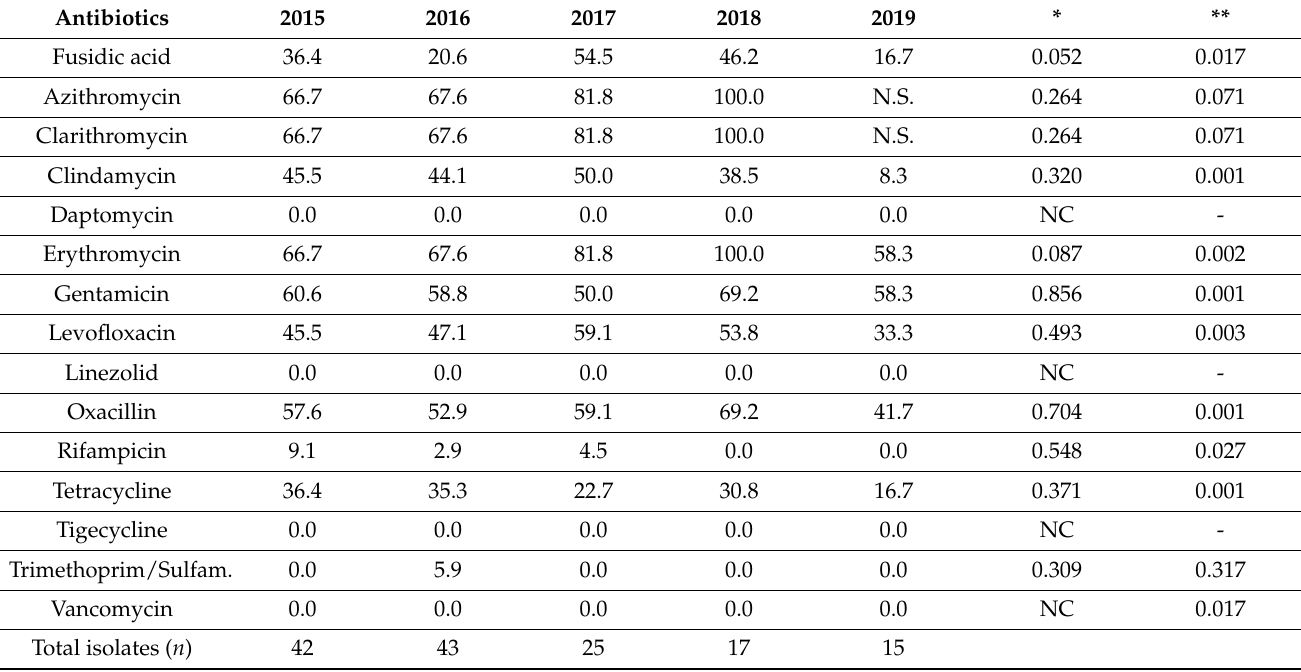
Table 5. Resistance rates (%) of coagulase-negative staphylococci isolated from ocular samples by